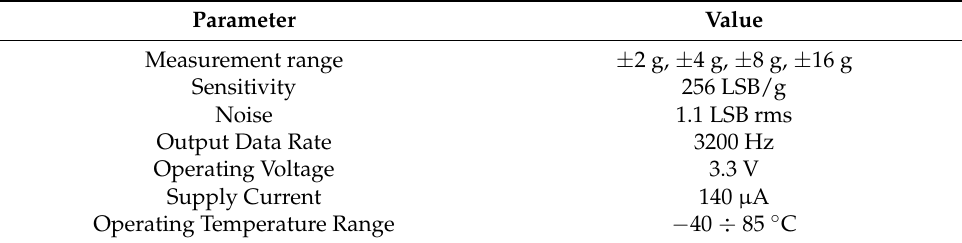
Table 4. Accelerometer main parameters.